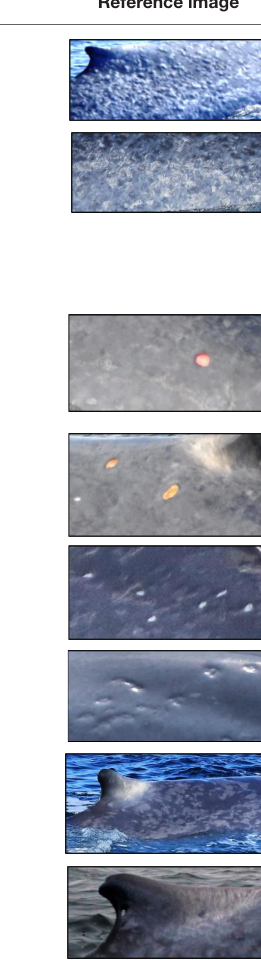
TABLE 1 | Definitions and reference images for each class and subclass of skin condition markings